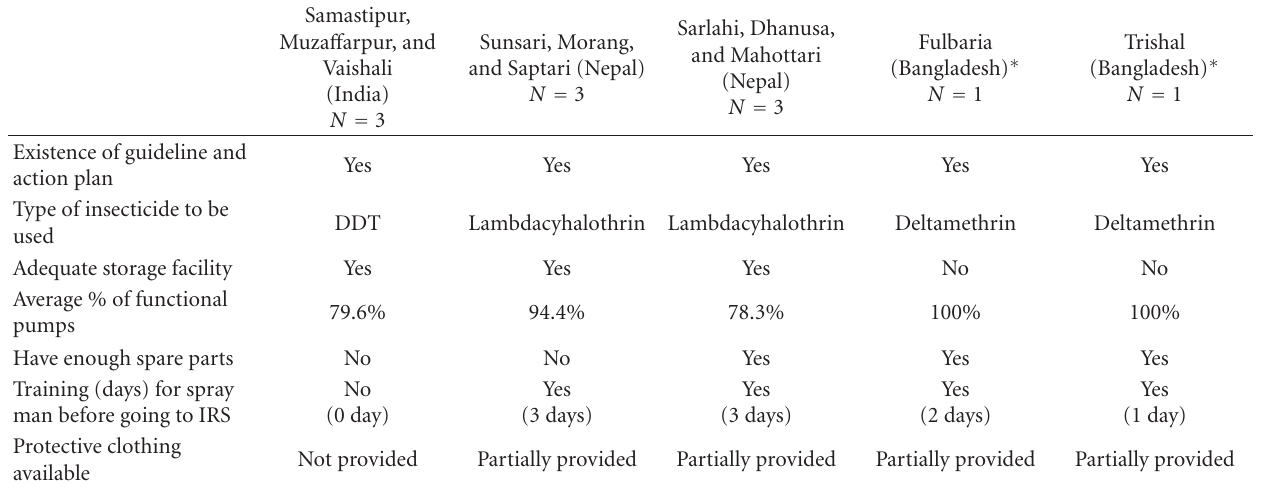
Table 1: Input indicators for IRS: availability of di ff erent resources for conducting